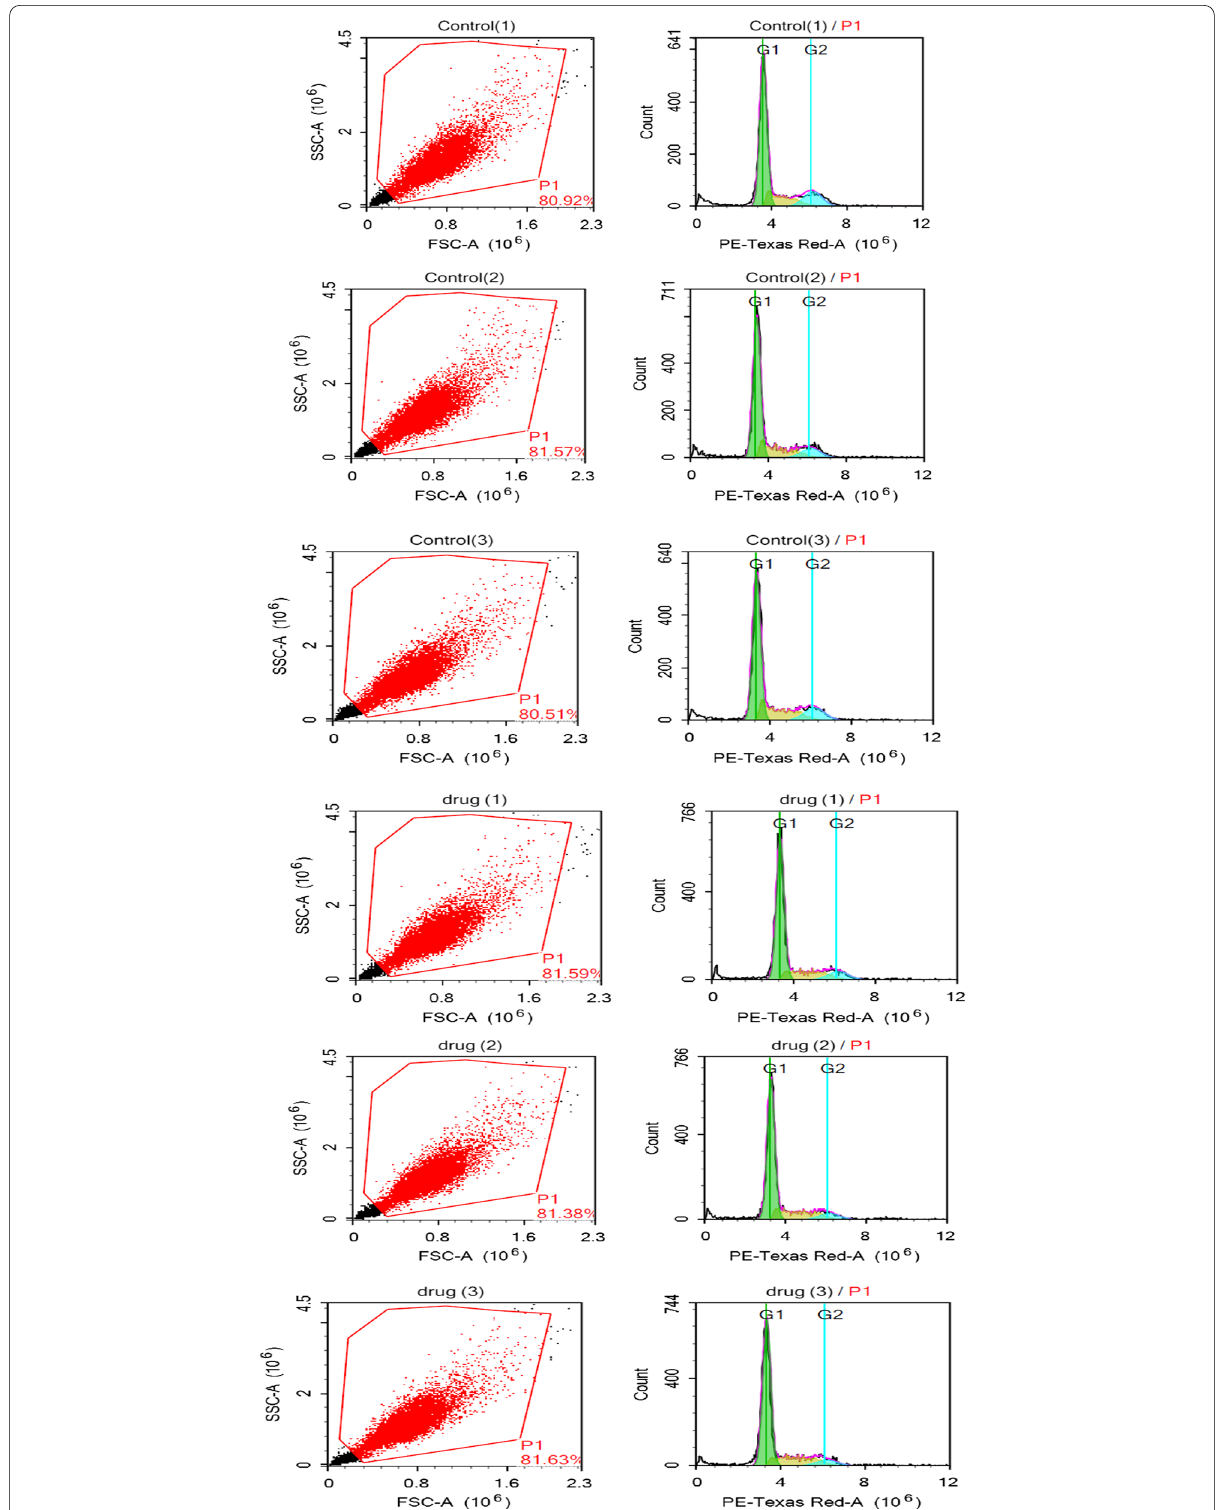
Fig. 7 Flow cytometry for cell cycle analysis of cultured HNO97 cells treated with apricot oil